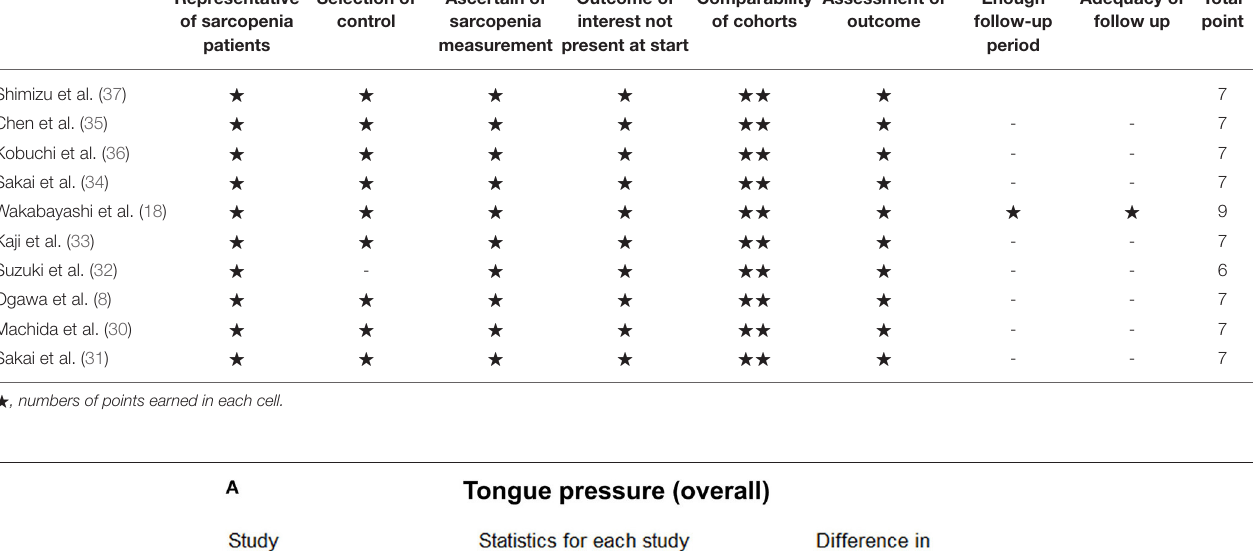
Frontiers in Nutrition |